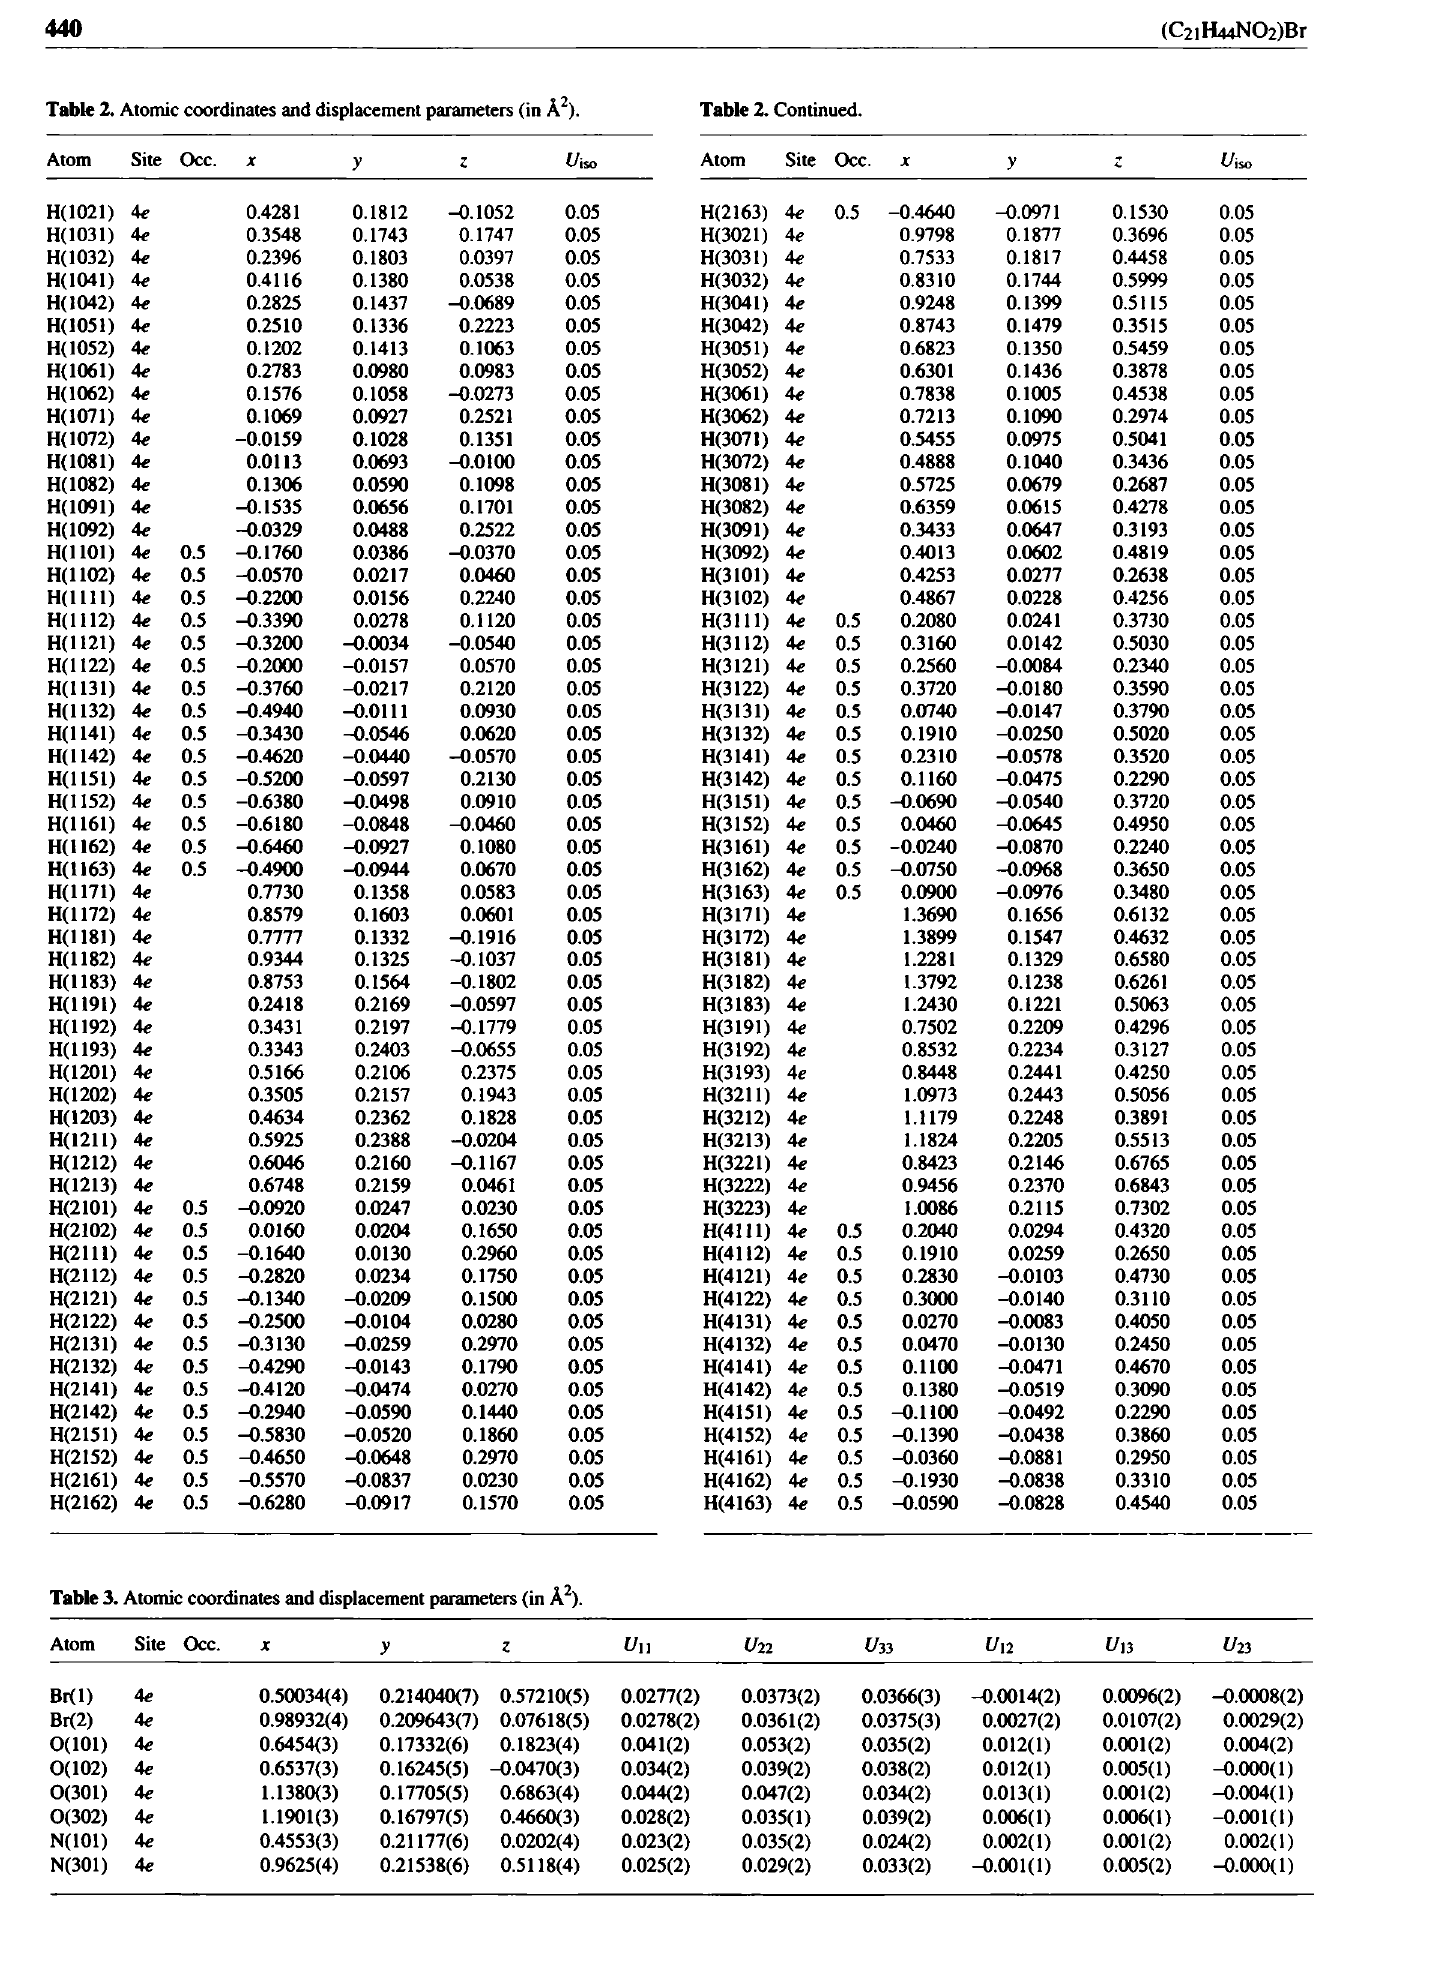
Table 2. Atomic coordinates and displacement parameters (in À 2 ).